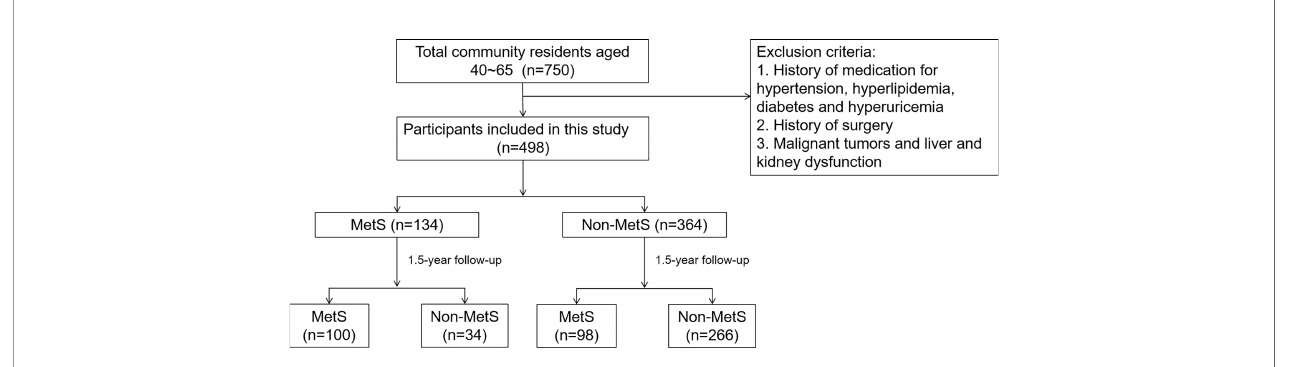
FIGURE 1 | Study fl ow chart. MetS,